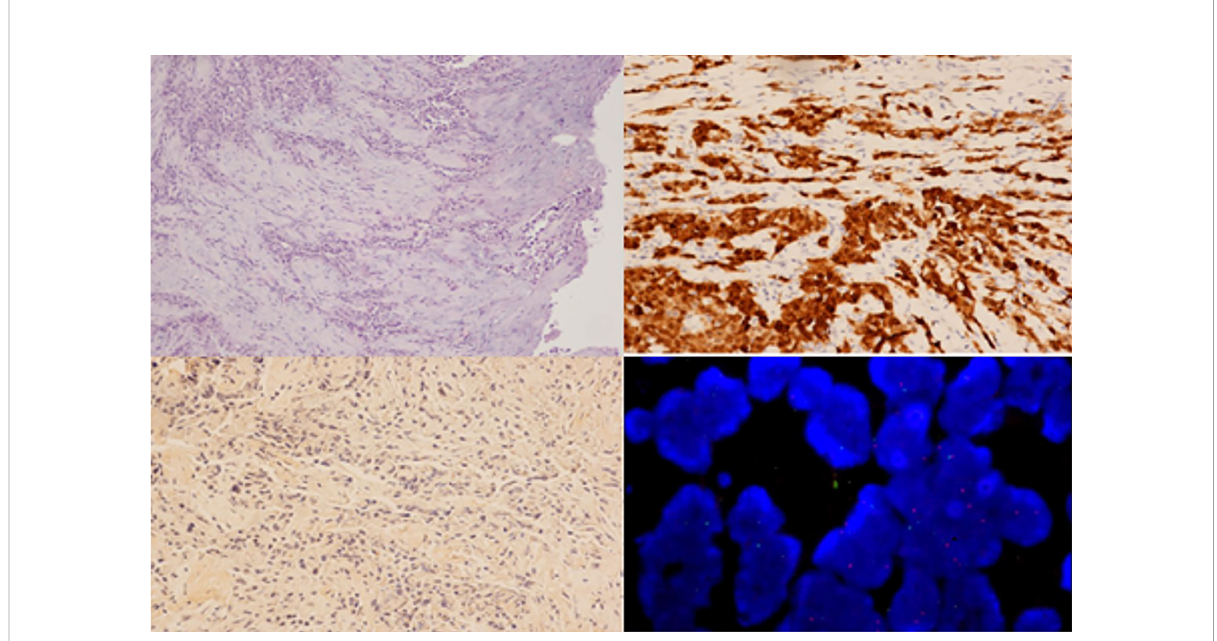
FIGURE 4 Sanger sequencing electropherogram and IGV alignment of the BAP1 variant